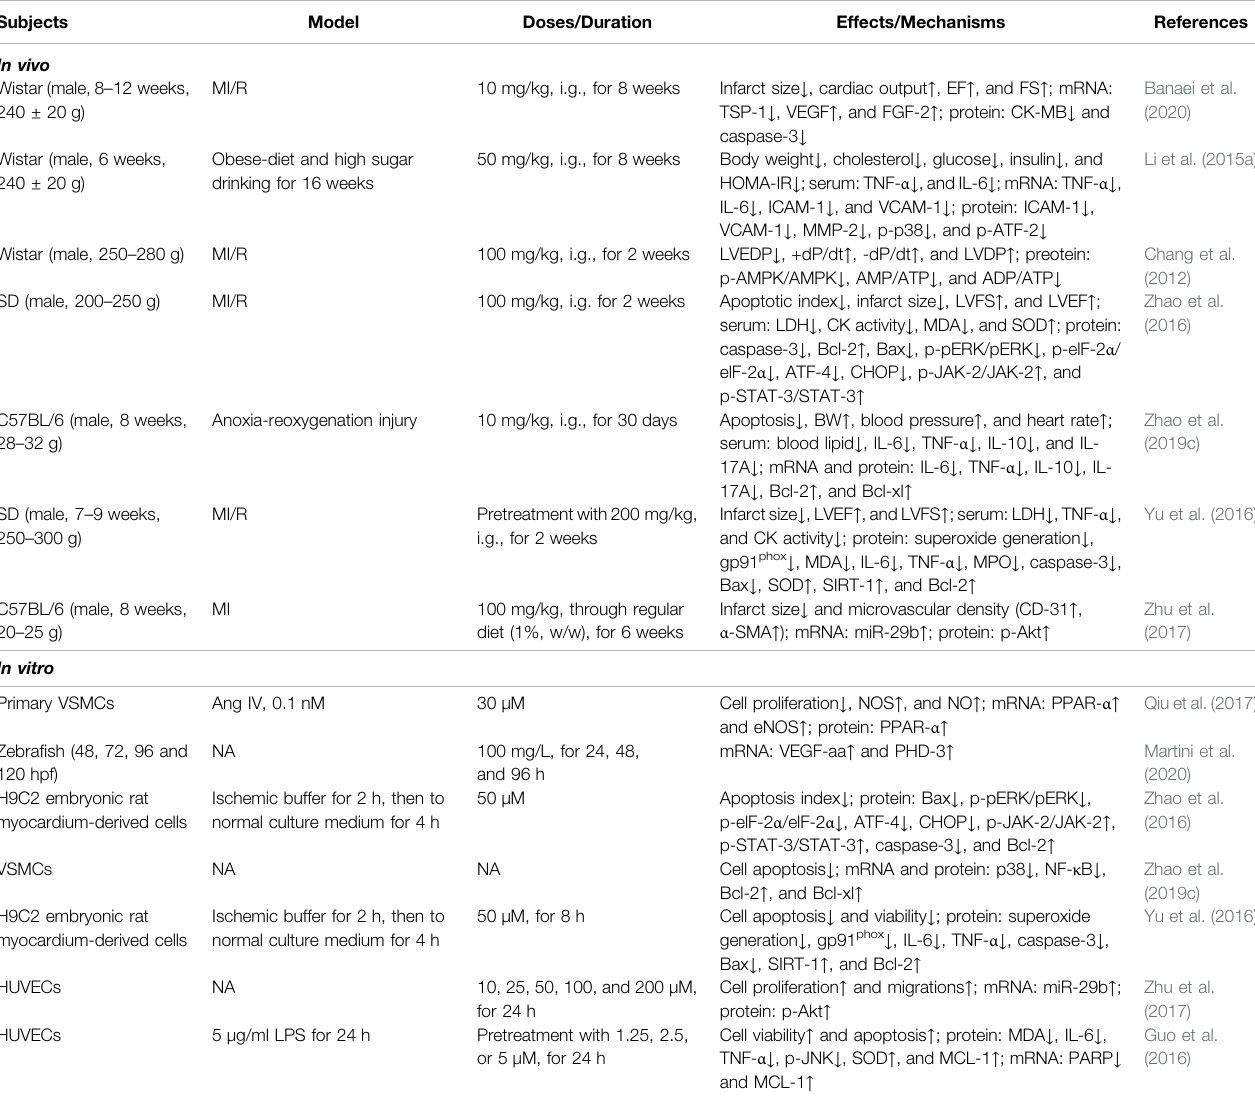
TABLE 1 | Pharmacological properties of berberine in vasculature in